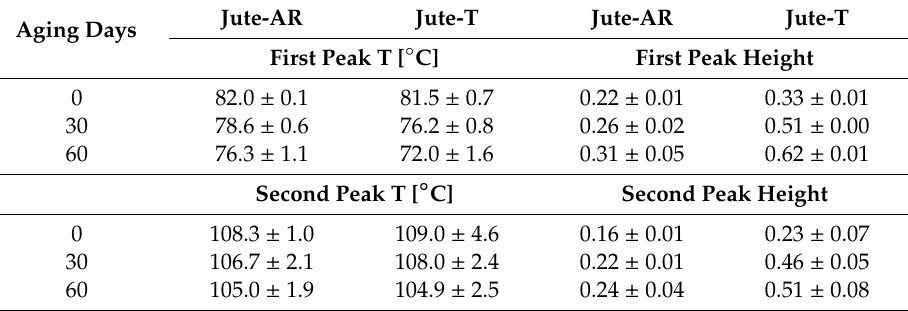
Table 3. Damping properties of jute composites for each aging